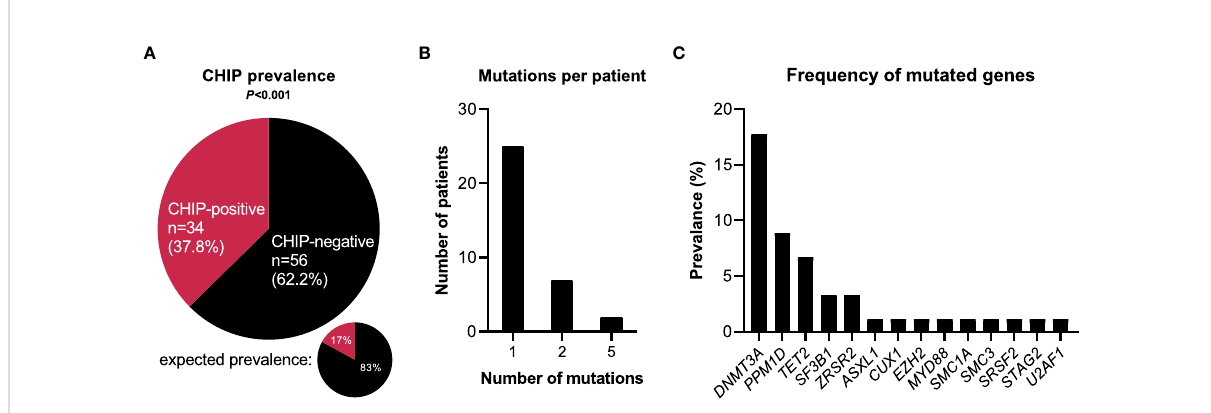
FIGURE 1 CHIP-associated mutations in hospitalized patients with COVID-19. (A) Prevalence of clonal hematopoiesis in hospitalized patients with COVID- 19. CHIP-positive = patients carrying at least one CHIP-driver mutation with a VAF ≥ 0.01. Expected prevalence according to Watson et al. (4). Observed and expected prevalence were compared using binomial test. Statistically signi fi cant results (P ≤ 0.05) are highlighted by bold print. (B) Number of individual mutations per CHIP-positive patient. (C) Prevalence broken down by affected